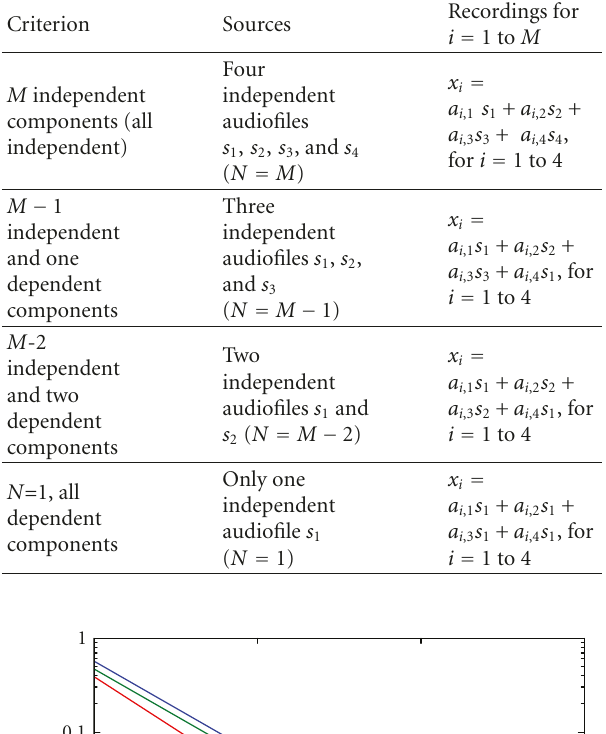
Table 1: Criterion of mixing sources to generate the four record- ings.